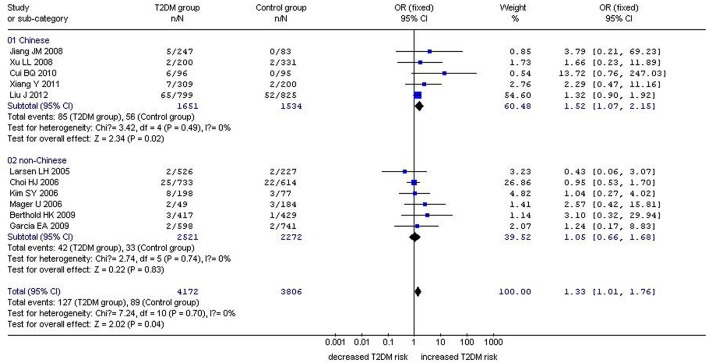
Forest plot of T2DM associated with GHRL gene Leu72Met (L72M) polymorphism under a recessive genetic model (MM vs. LM+LL). Under the recessive genetic model, a significant correlation between the GHRL Leu72Met gene polymorphism and T2DM was found (OR: 1.33, 95% CI: 1.01–1.76, P = 0.04). A more pronounced correlation between them was found (OR: 1.52, 95% CI: 1.07–2.15, P = 0.02) in the Chinese population. No significant correlation was detected in the non-Chinese population (OR: 1.05, 95% CI: 0.66–1.68, P = 0.83).